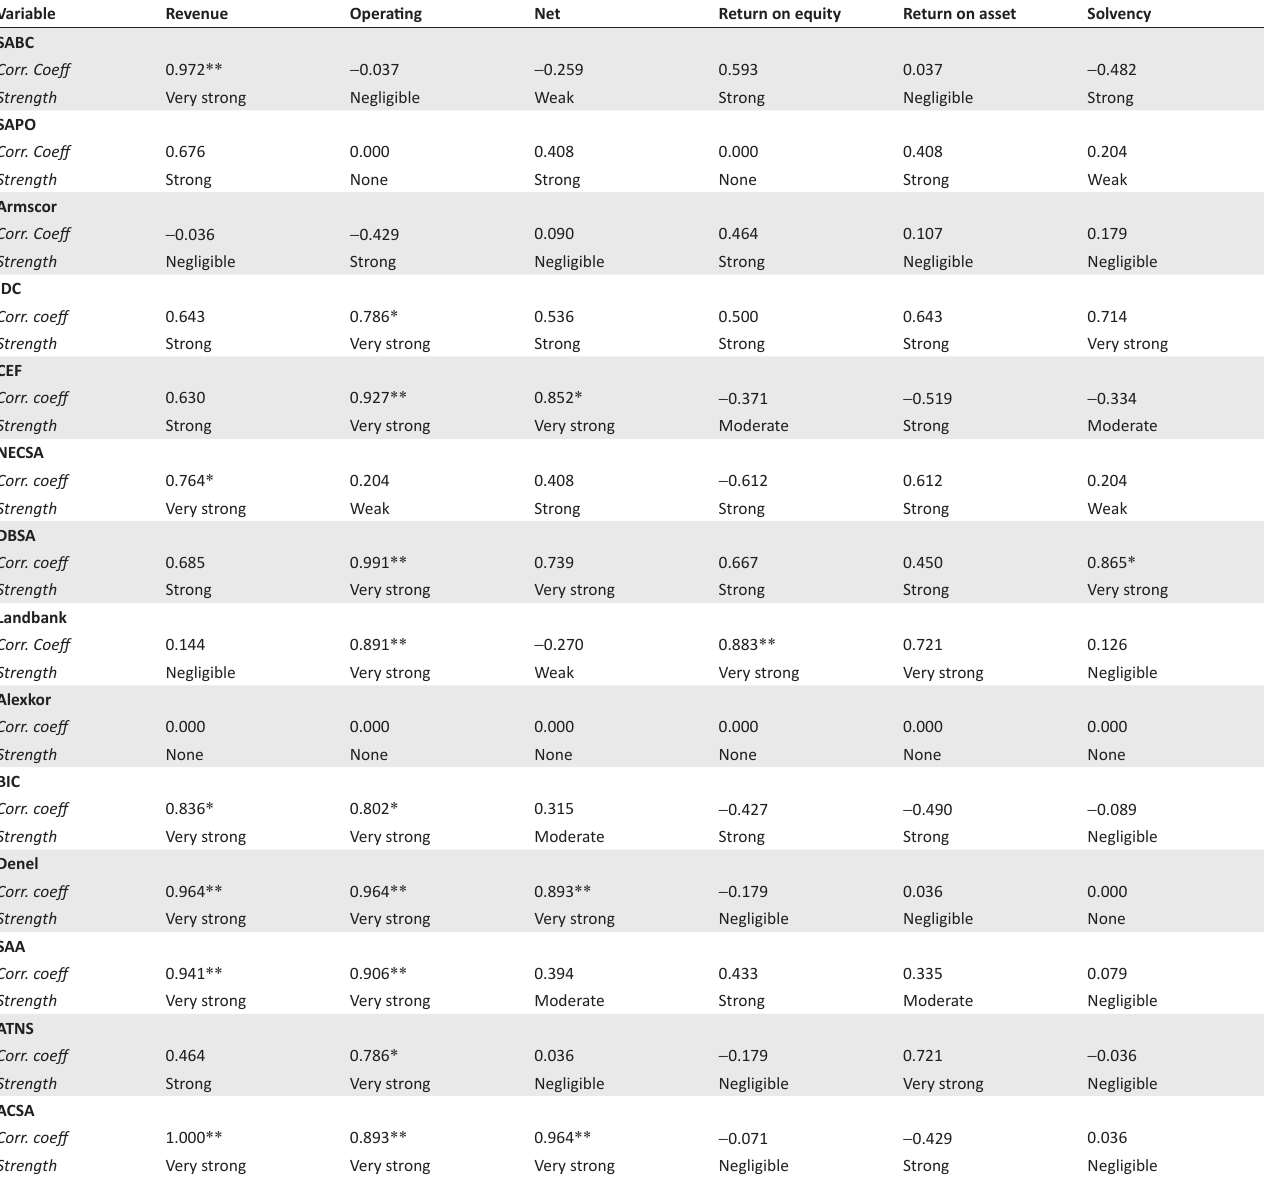
TABLE 3: Relationship significance and strength between total pay and company performance over the research period.